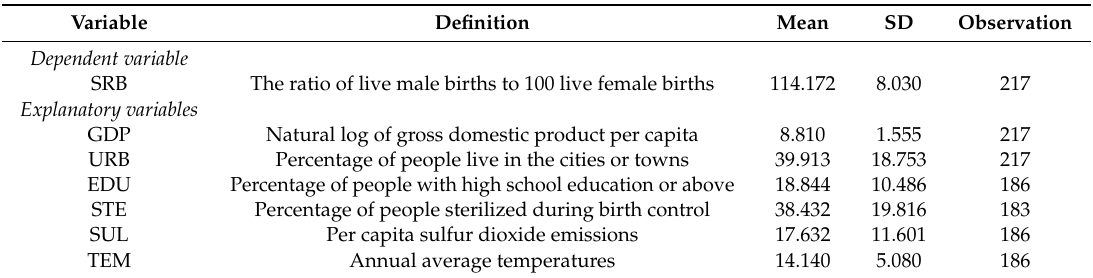
Table 1. Descriptive statistics for SRB (sex ratio at birth) and explanatory